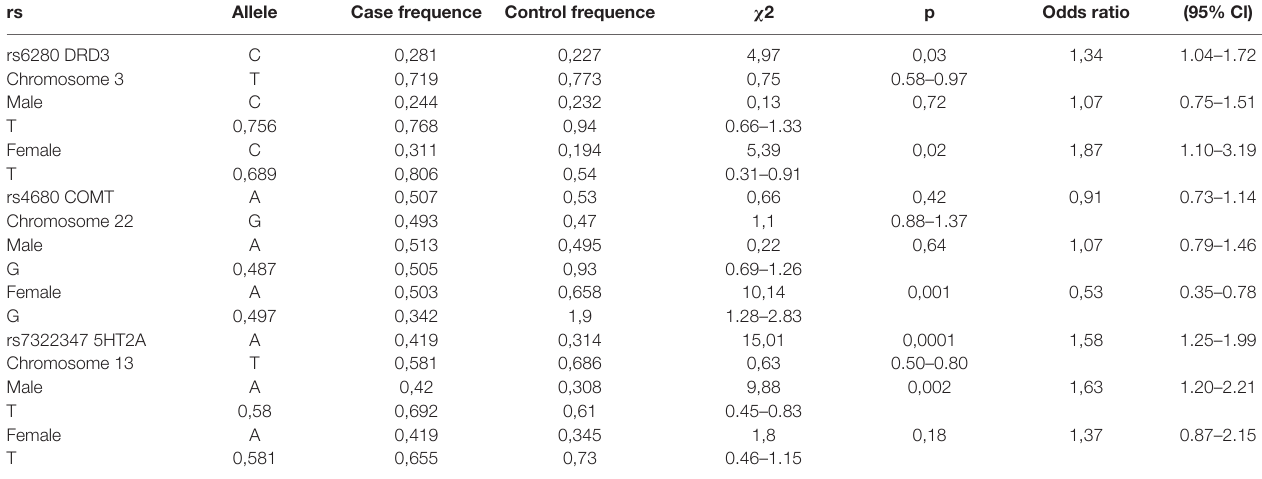
TABLe 2 | Distribution of DRD3 , COMT , and 5HT2A polymorphisms in youth-onset schizophrenia and control groups. rs